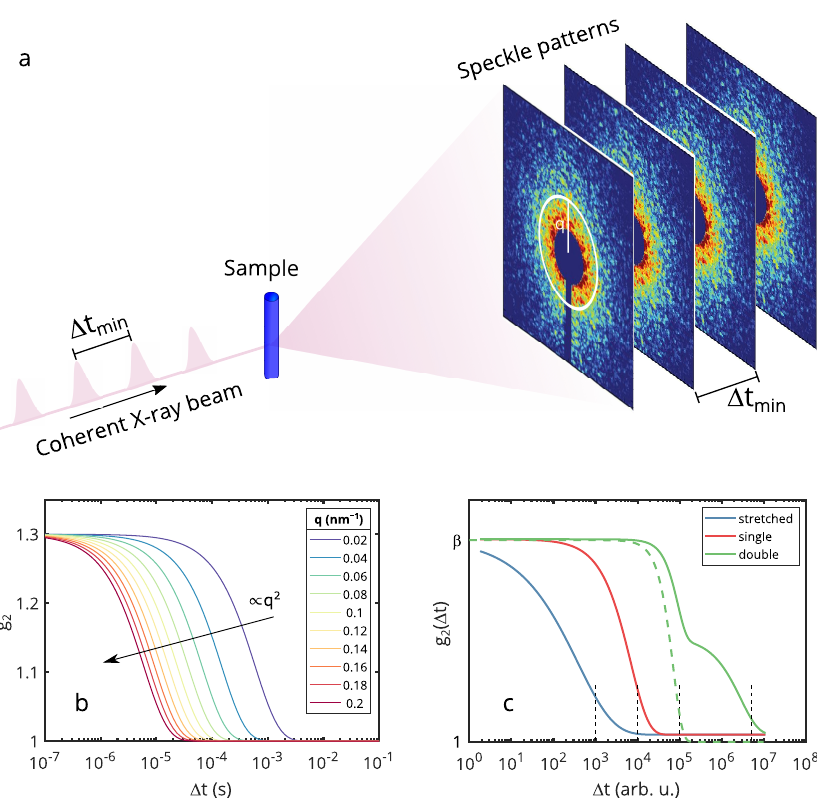
Figure 3. ( a ) XPCS scheme in small-angle X-ray scattering (SAXS) geometry . The speckle patterns are recorded with repetition rate of 1/ ∆ t min several meters downstream of the sample. Adapted from [48]. ( b ) Calculated g 2 functions for nanoparticles with radius of 50 nm dispersed in water at room temperature. The speckle contrast is set to β = 0.3. The q 2 -dependence of the relaxation time is visible by the non-equidistant functions. ( c ) g 2 showing different shapes: stretched with γ = 0.5, single exponential, and double exponential with 1:1 contribution of the two decays. The first decay is compressed ( γ = 2) and is additionally shown as single curve as dashed green line. The dashed black lines mark the corresponding relaxation times found at β exp ( − 2 )